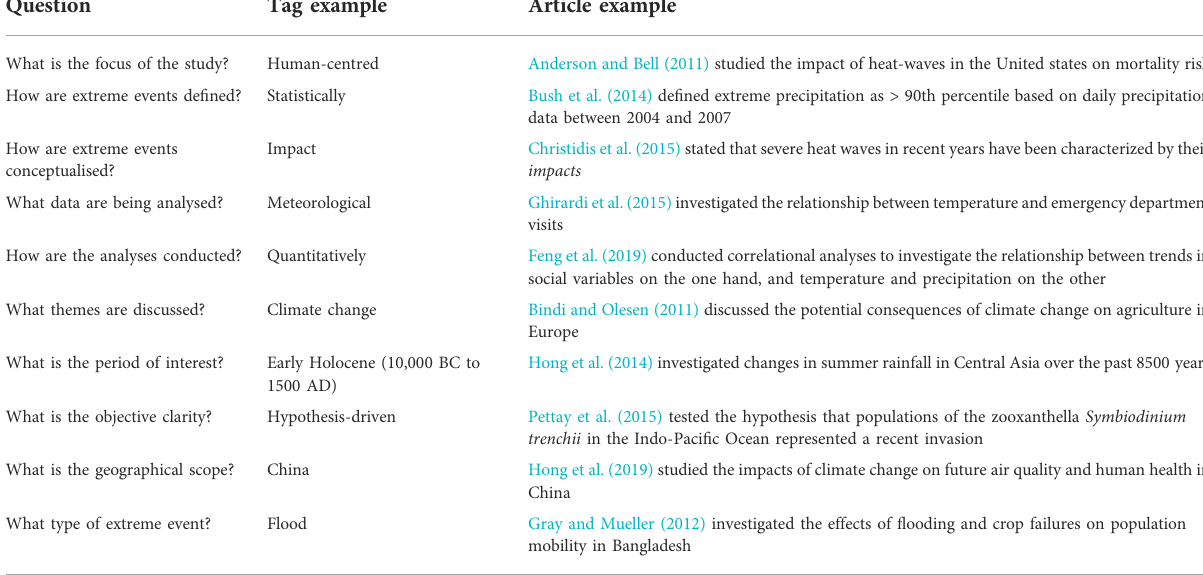
TABLE 2 The 10 questions asked of each paper and